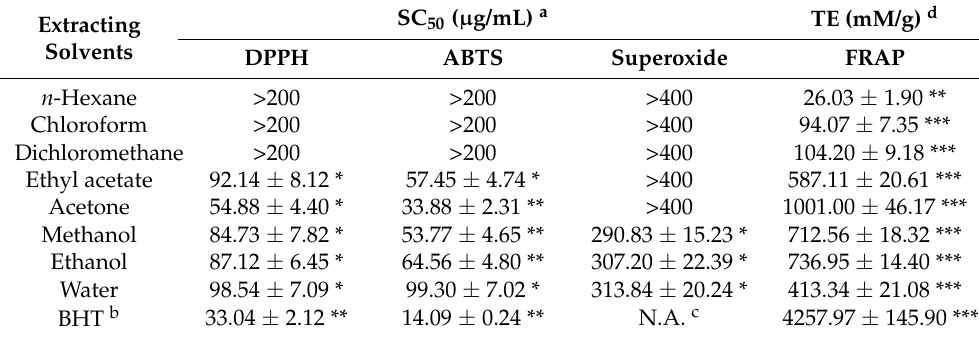
Table 2. Antioxidant effects of various solvent extracts from Ampelopsis japonica determined by DPPH, ABTS, superoxide radical scavenging, and FRAP